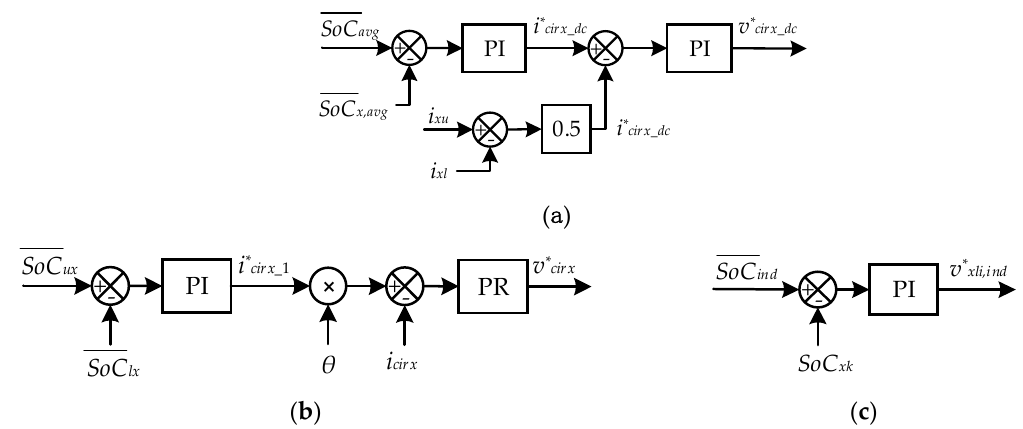
Figure 12. SoC balancing control: ( a ) Leg SoC balancing control; ( b ) Arm SoC balancing control; ( c )